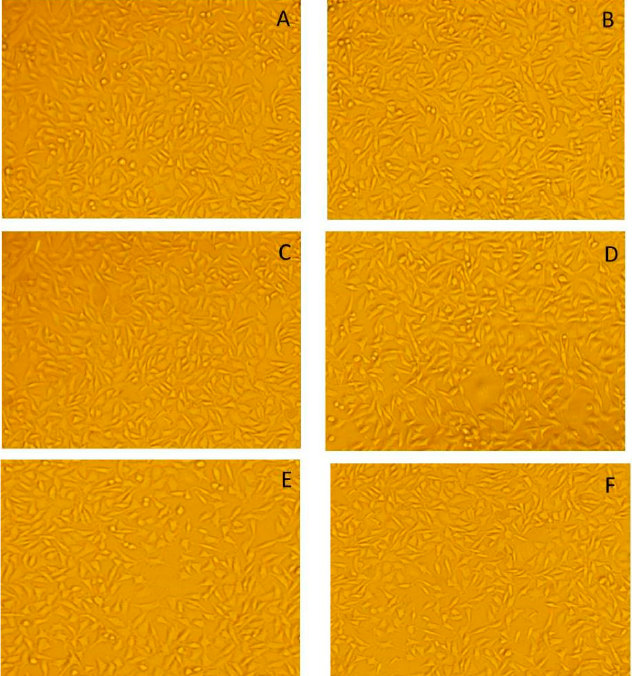
Figure 9. Morphology of cells in ( A ) Control group at day 1, ( B ) TiO 2 nanoparticle-treated cells at day 1, ( C ) Control group at day 7, ( D ) TiO 2 nanoparticle-treated cells at day 7, ( E ) Control group at day 30, ( F ) TiO 2 nanoparticle-treated cells at day